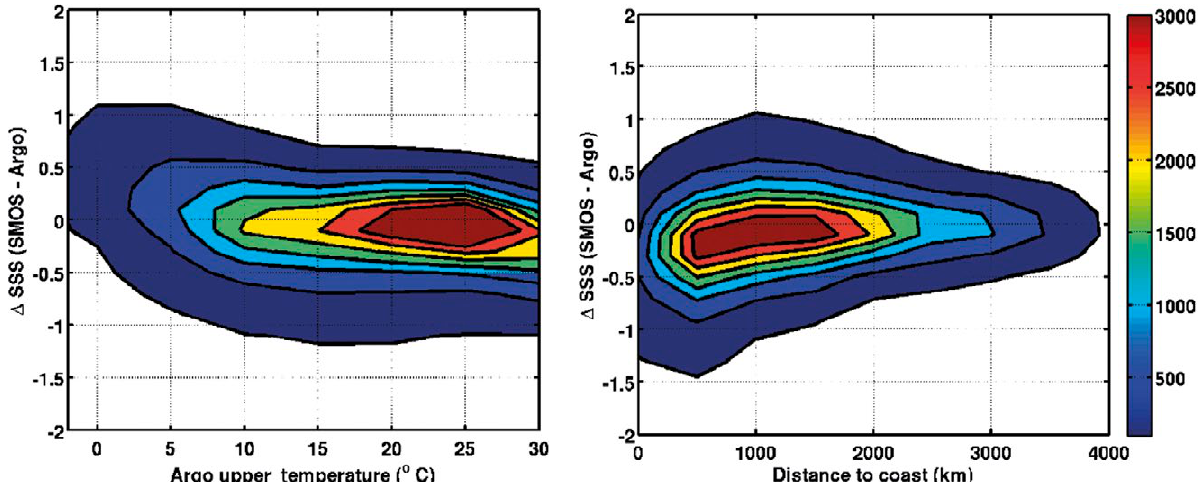
Fig. 9. – Bidimensional histogram of the salinity difference between SMOS and Argo as a function of the uppermost temperature measured by Argo (left) and as a function of the distance to the coast (right). These plots have been created using only Delayed Mode Argo profiles. Colour indicates the number of SMOS/Argo